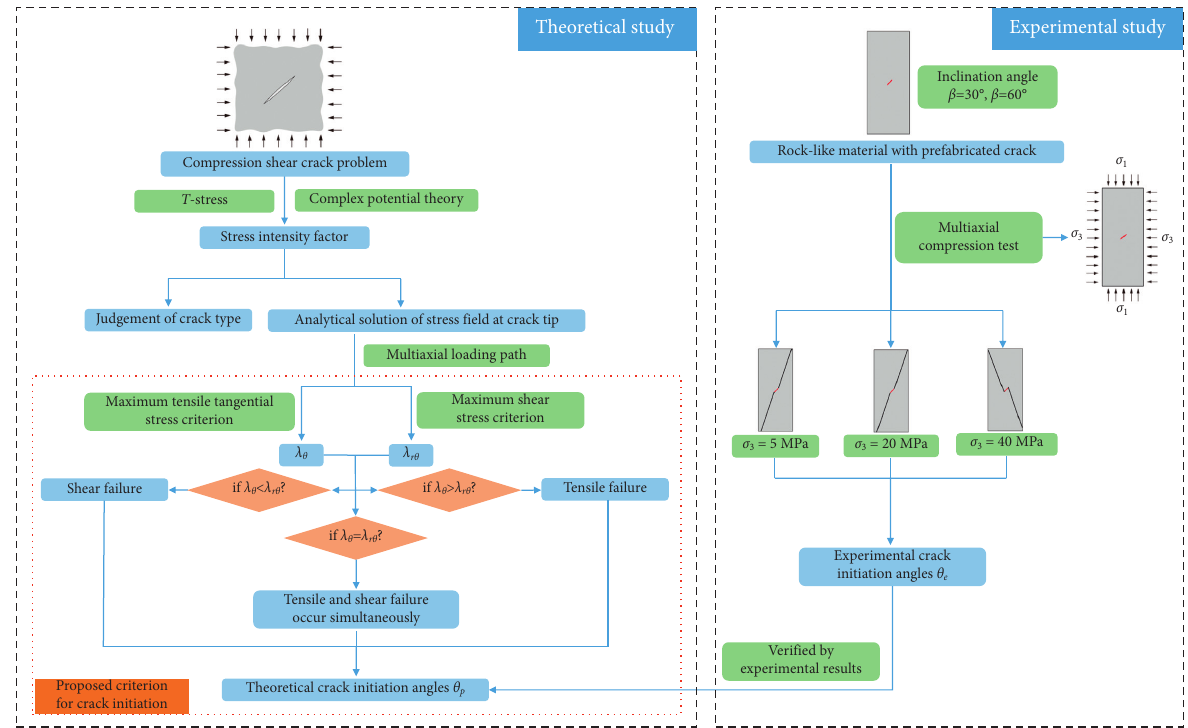
Figure 1: Flowchart for analyzing the fracture behavior of compression-shear crack.